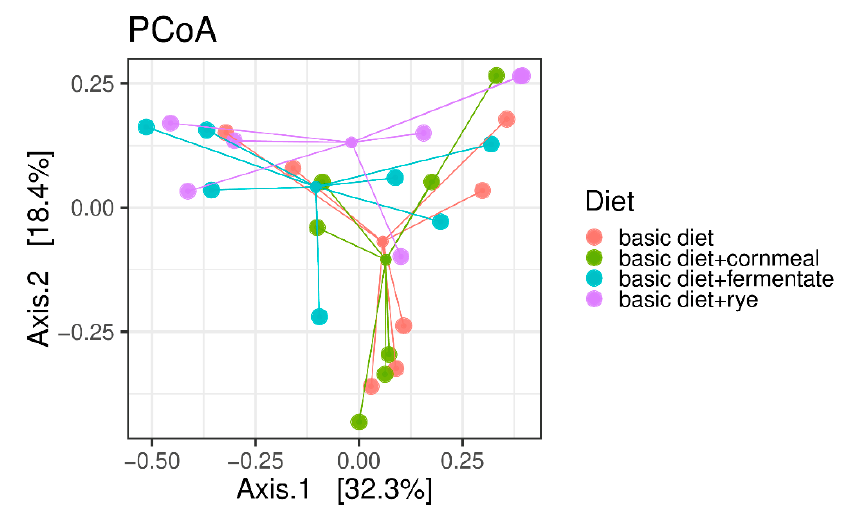
Figure 1. Bray–Curtis dissimilarity-based principal coordinate analysis (PCoA). Each point represents